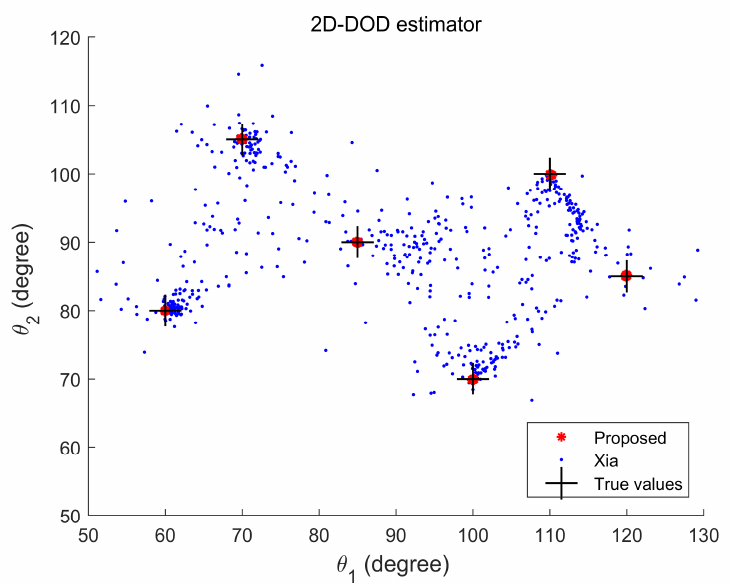
Figure 4. Two dimensional (2D)-direction of departure (DOD) scattergram of six targets for mixed signals.